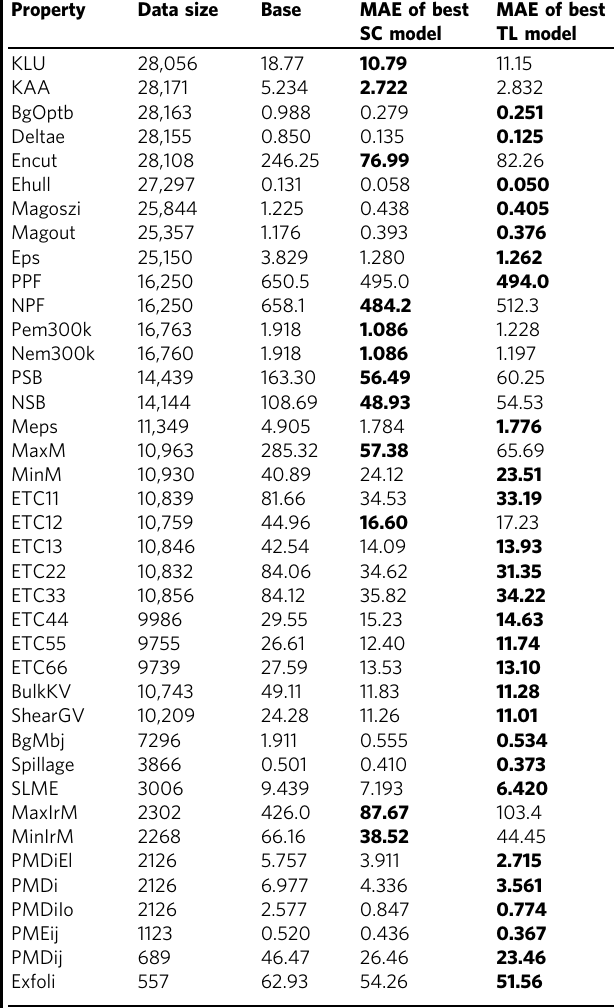
The table shows the test MAE of the best model selected using Supplementary Table 9 (based on validation MAE) when run on the test set for each of the target materials properties. The selected modeling con fi gurations are listed in Supplementary Table 10. The SC models are allowed to use PA as input as well, while TL models only use EF-based inputs. The lowest MAE values in each row are highlighted in